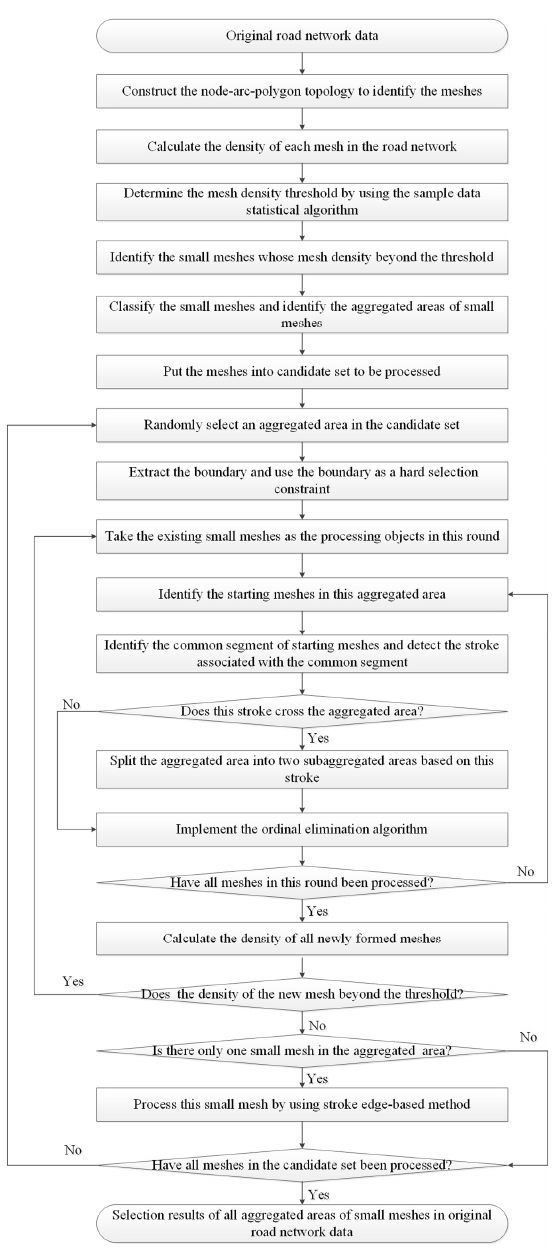
Figure 9. Flowchart of the proposed method.